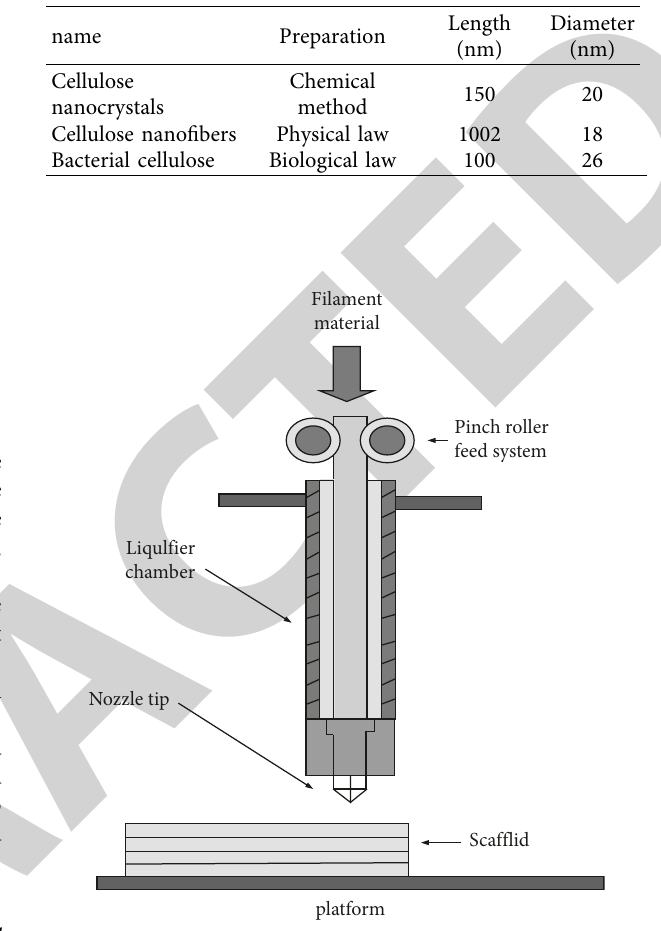
Figure 2: Schematic diagram of the structure of a typical high- pressure homogenizer.